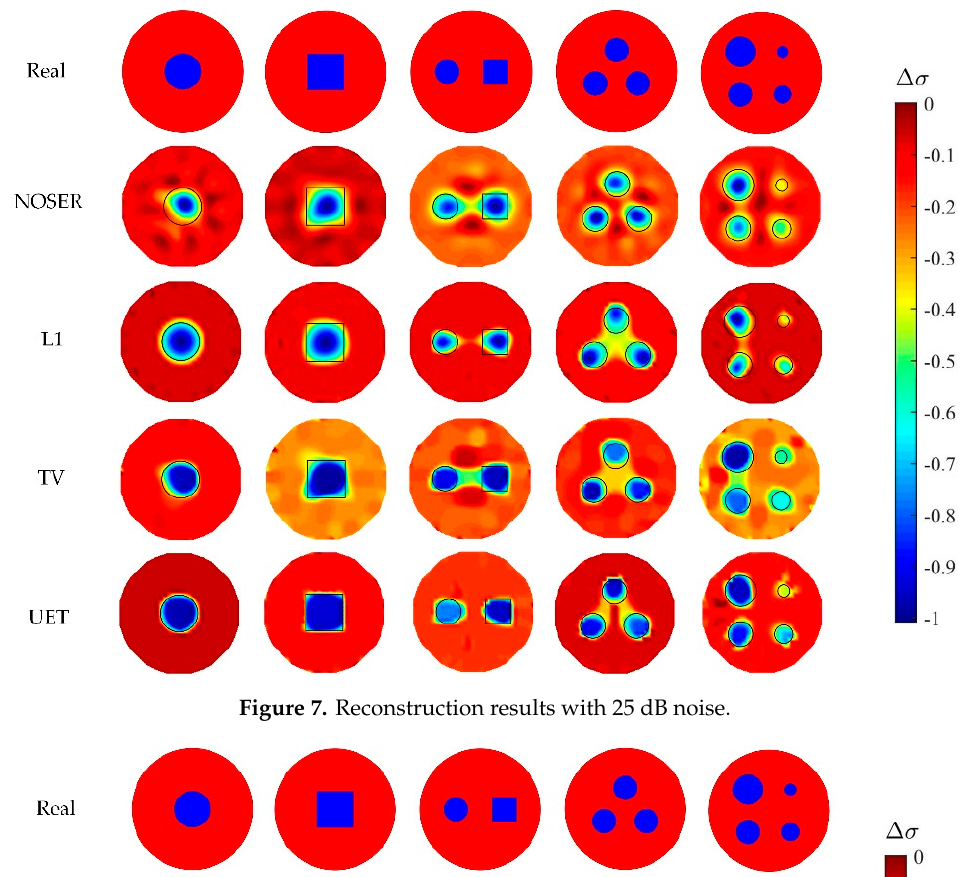
Figure 7. Reconstruction results with 25 dB noise.